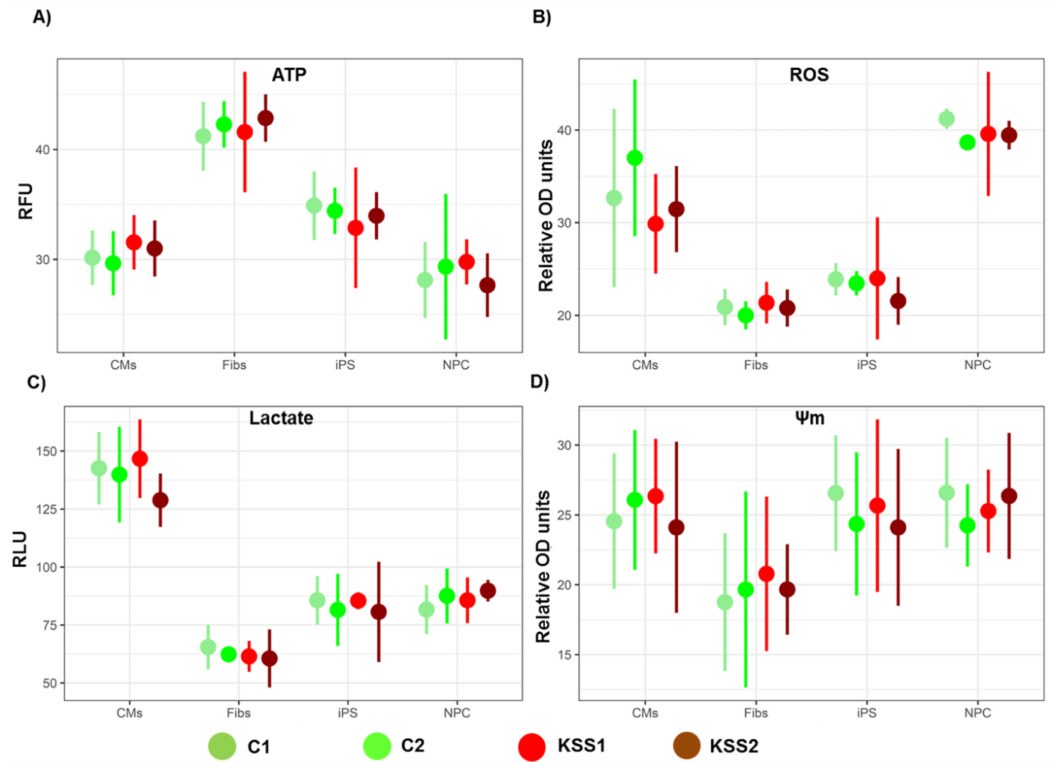
Figure 4. Patient peripheral blood mononuclear cells (PBMNC) derived induced pluripotent stem cells (iPSC) and differen- tiated cells did not show any aberrant deviations in the cellular physiology. ( A ) Total ATP production in iPSC, fibroblasts, Neural progenitor cells (NPC) and Cardiomyocytes (CM) was measured using a commercial kit. ( B ) Reactive Oxygen species (ROS) estimation was carried out in iPSC, fibroblasts, NPC and CM using a fluorescent dye 2 (cid:48) ,7 (cid:48) -dichlorodihydrofluorescein diacetate (H2DCFDA). ( C ) Lactate accumulation in iPSC, fibroblast, NPC and CM was assessed using luminometric analyses. ( D ) Mitochondrial membrane potential ( Ψ m) in iPSC, fibroblasts, NPC and CM was estimated using Tetramethylrhodamine, ethyl ester (TMRE) assay. n = 3, each experiment was repeated 3–4